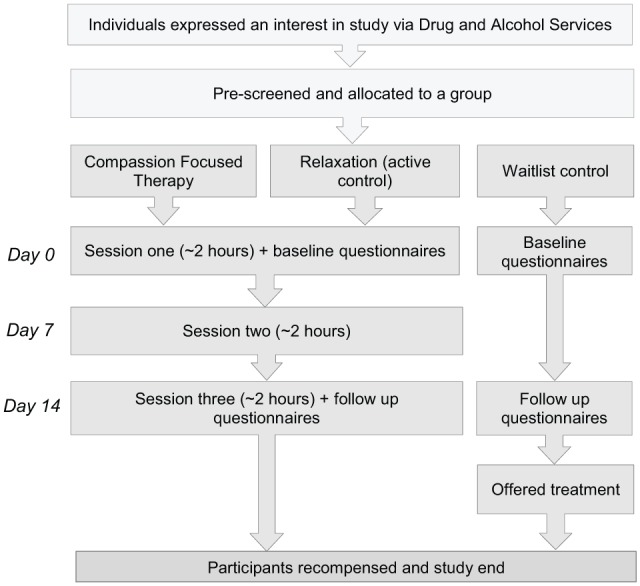
The study procedure.